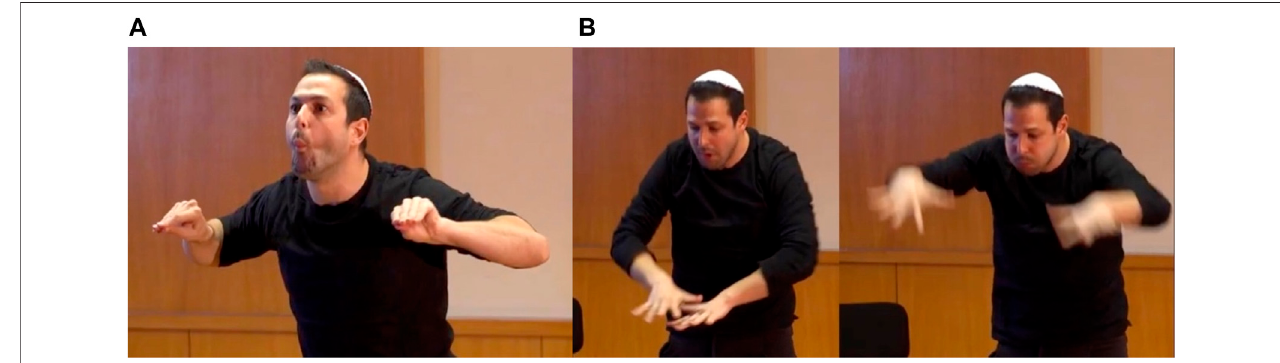
FIGURE 13 | Iconic mouth gestures: (A) “ emptiness, void ” with sucked in mouth and cheeks and closed fl at-hands suggesting an empty surface, (B) “ rising, spreading mass (water) ” puf fi ng mouth and cheeks and opening and spreading hands, suggesting a wide, fl at